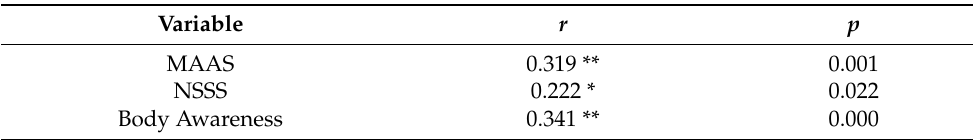
Table 4. Spearman correlations of the variable quantity of Mindfulness practice with the MAAS, NSSS and body